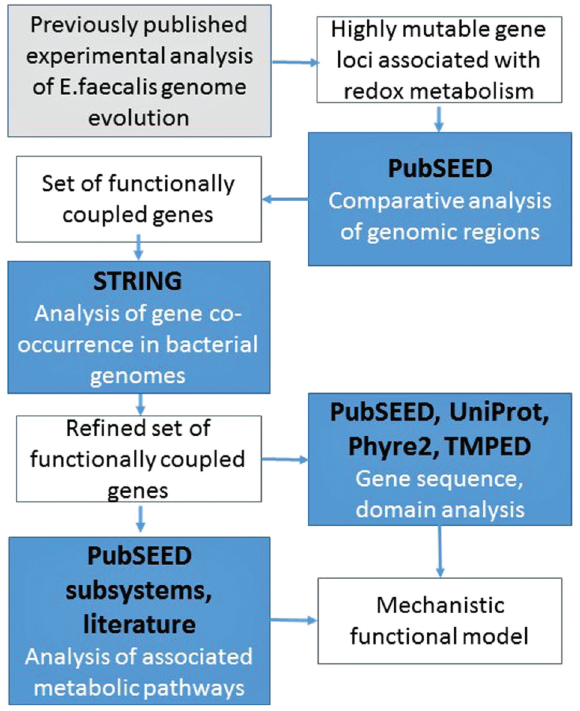
(SEED ID: fig|226185.9.peg.3033) were retrieved for the comparative analysis. ‘ Compare region ’ application has been used for the homologous bacterial genomic regions retrieval (set e-20 similarity threshold) and struc- tural comparison. ‘ Compare regions ’ diagrams present homologous genes as same color-coded arrows with the same associated number (a direction of an arrow indicates the coding vector). The regions are aligned (pinned) via the seed gene homologs (presented as N1, red in all the